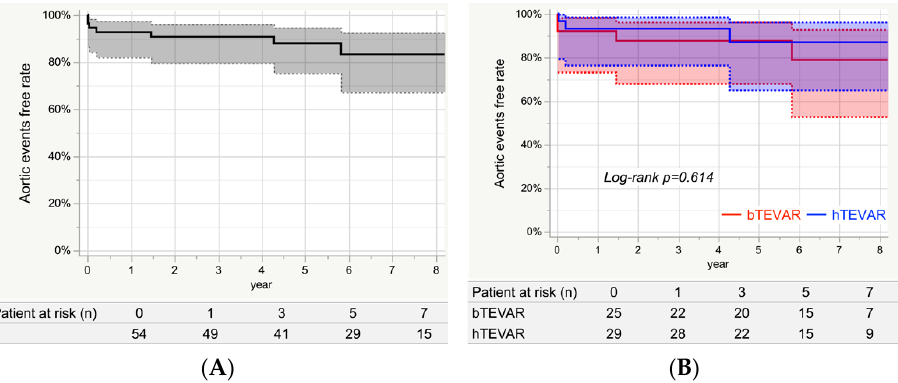
Figure 4. Freedom from aortic events. ( A ) The event-free rates at 1, 3, 5, and 7 years were 92.6% (95% CI: 81.9 – 97.2%), 90.6% (95% CI: 79.4 – 96.0%), 87.9% (95% CI: 75.2 – 94.5%), and 83.3% (95% CI: 67.1 –